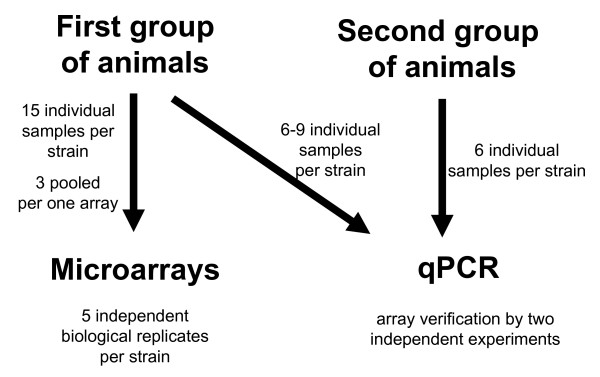
Experimental design. Biological replicates, sample pooling and validation of presented gene expression comparison of the four inbred mouse strains were performed using strategy described by the scheme. Five independent biological replicates of microarray were prepared for each strain of mice. Total RNA isolated from the striatum of three animals was pooled. Each pool of total RNA was separately converted to cRNA and hybridized to a single microarray. Samples from two separate groups of animals from each strain of mice were used in qPCR experiment.